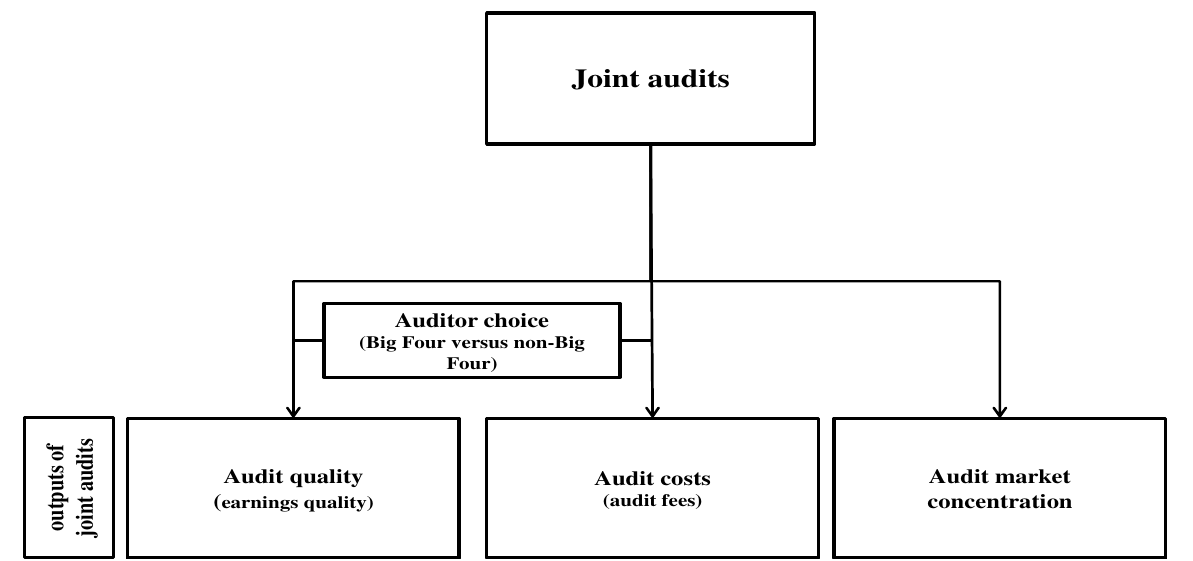
Fig. 1. Joint audit research